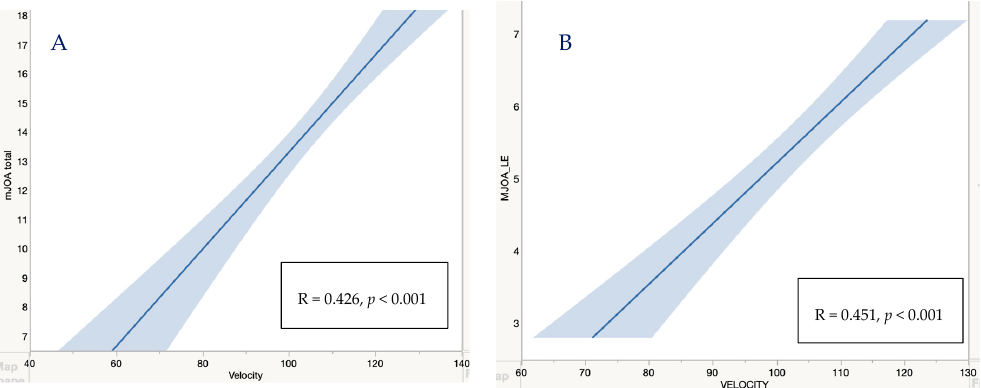
Figure 2. We observed a significant decrease in velocity with decreased mJOA score ( A ) and decreased mJOA LE subscore ( B ).